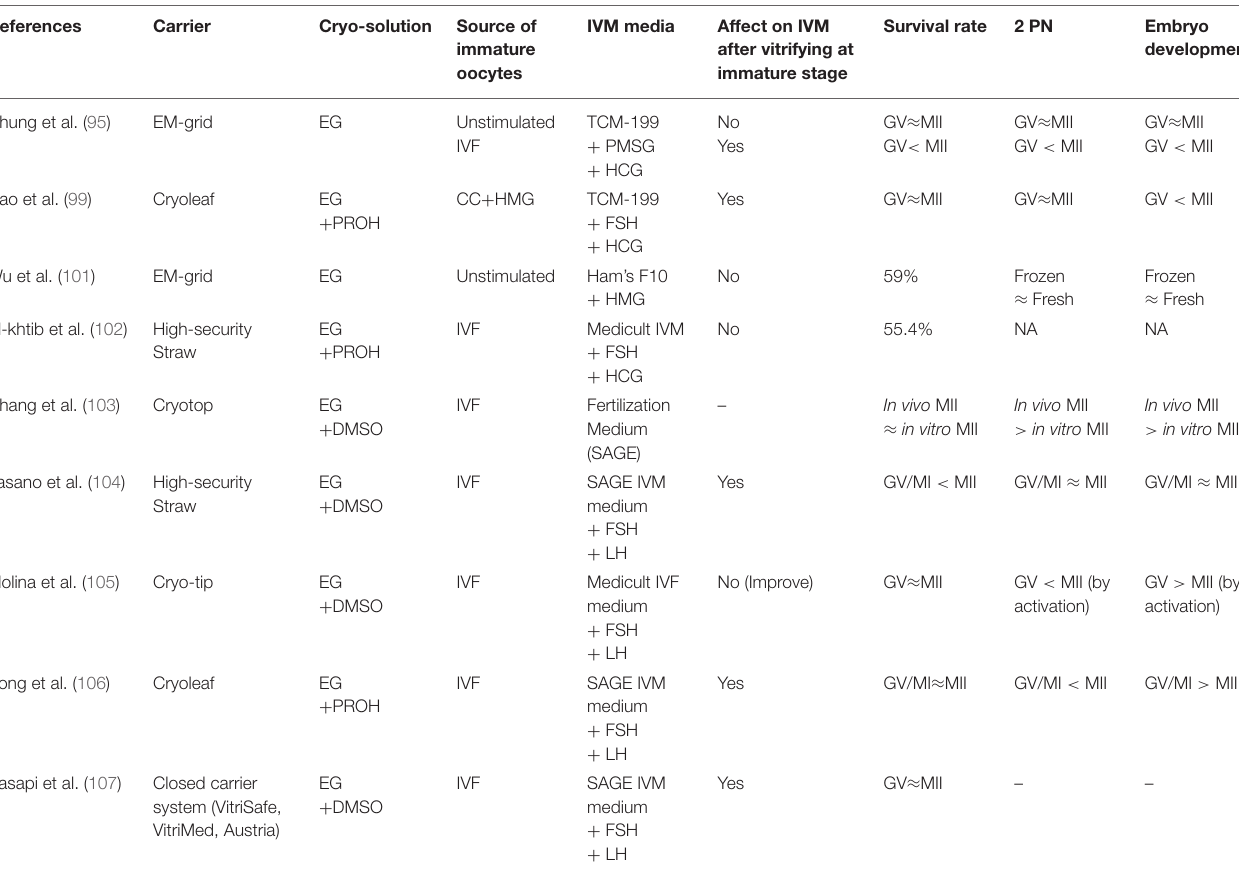
TABLE 2 | Summary of IVM oocyte vitrification